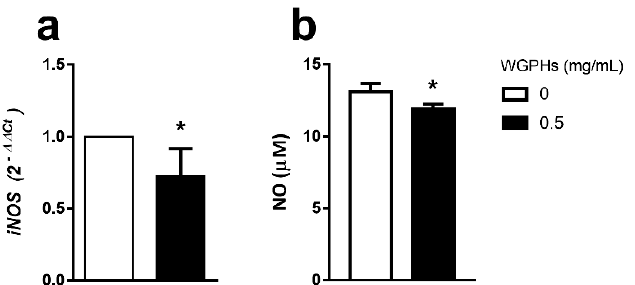
Figure 5. ( a ) Relative gene expression of inducible nitric oxide synthase (iNOS) in PHA-stimulated PBMCs after overnight treatment with 0.5 mg / mL WGPHs. The data represent the mean of the values calculated with respect to PHA-stimulated, untreated cells with the 2 − ∆∆ C t method, and the standard error of the mean of each group ( n = 6). ( b ) The concentration of nitric oxide (NO) in the supernatants from overnight non-stimulated cells cultured with 0.5 mg / mL WGPHs. The data represent the mean and standard error of the mean of the percentage of each group ( n = 32). * p ≤ 0.05 with respect to the control group (WGPHs 0 mg / mL).